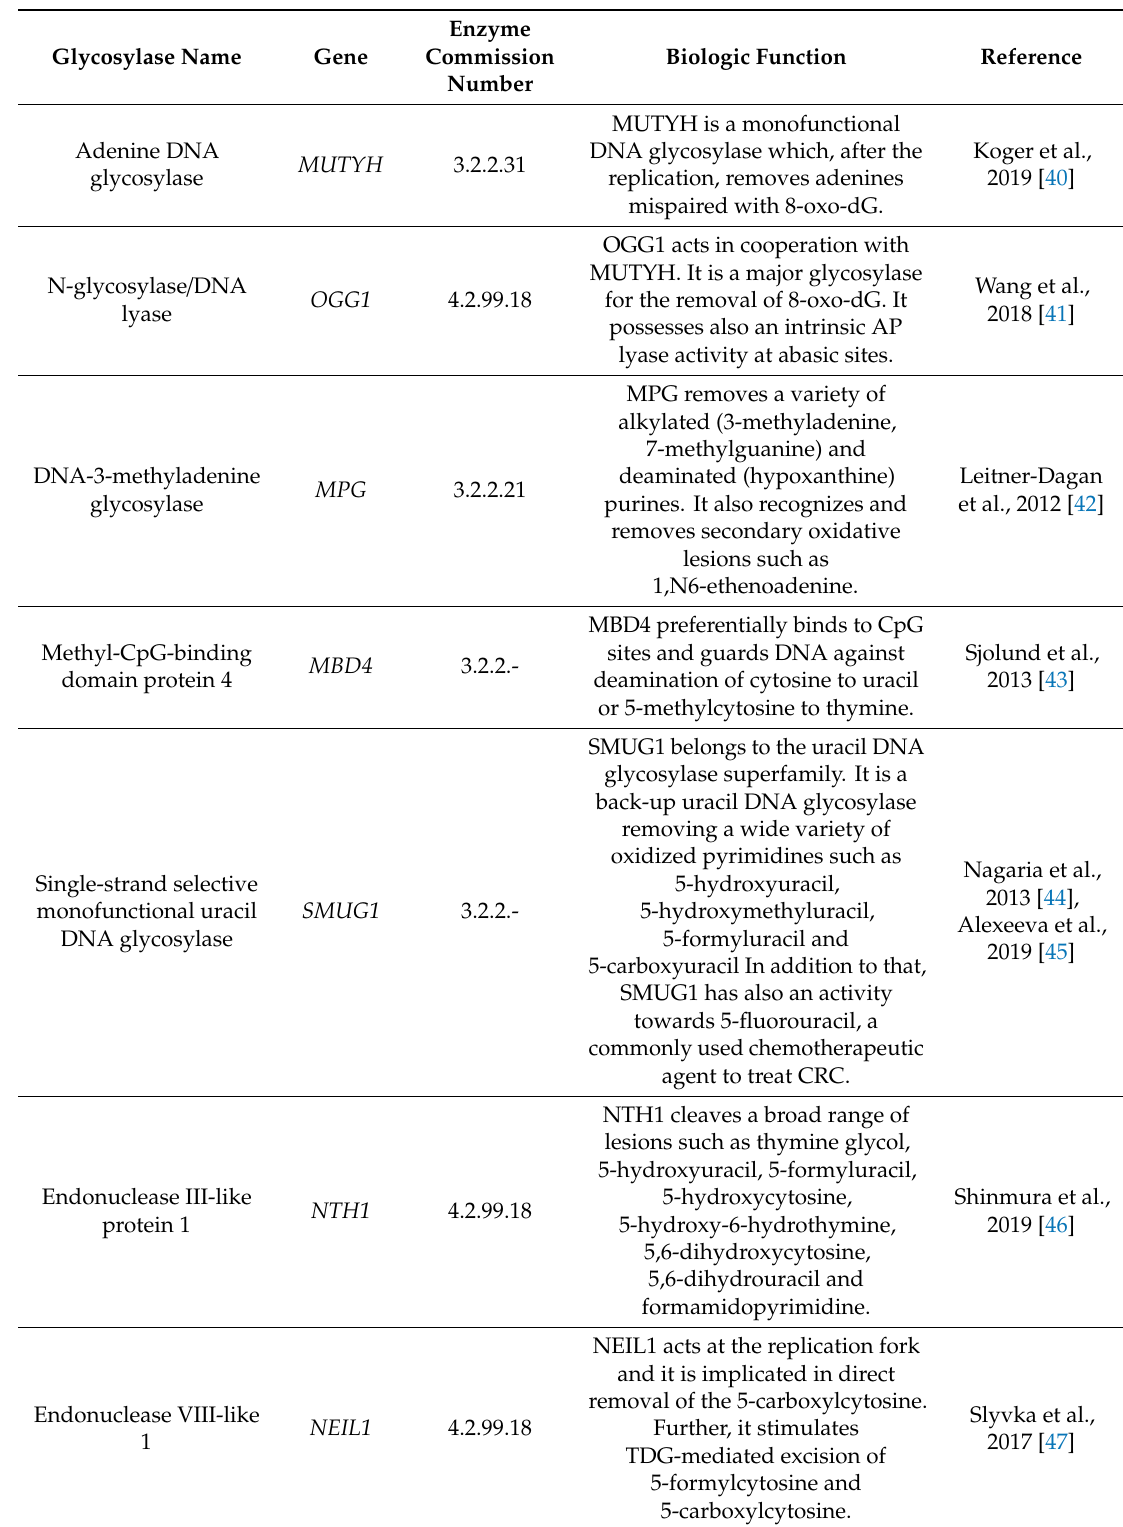
Table 1. List of human DNA glycosylases and their